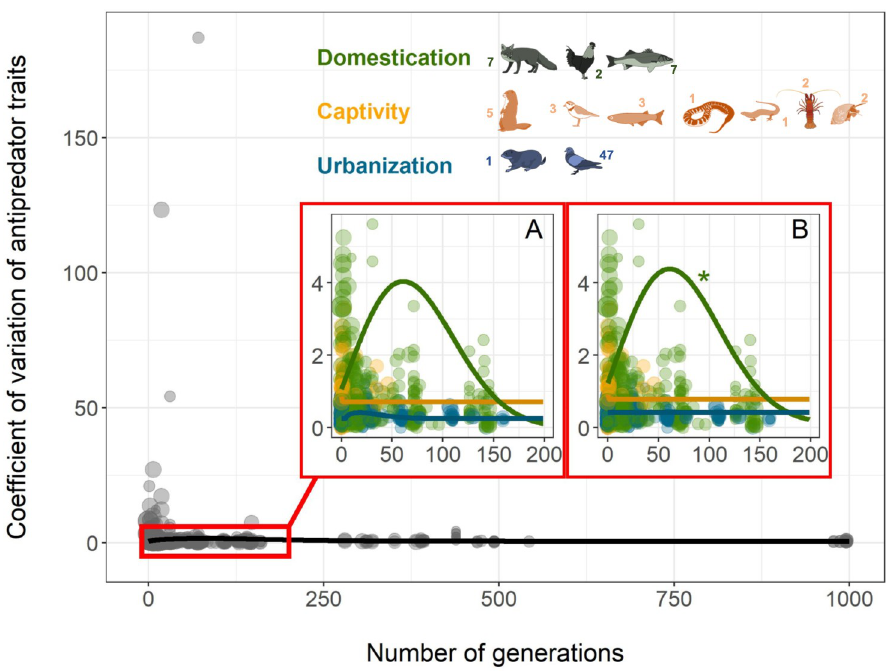
Fig 2. Effects of human presence over time on the CV in antipredator traits, black line (all contexts). (A) Lines correspond to the best loess fitting the data using the cma-es function. (B) Lines correspond to the best Weibull model with the outputs (slopes and intercepts) of the MCMCglmm for the CV. Dot size is proportional to the log- transformed number of replicates used in each study. “ � ” indicates significant p -value < 0.05 of the Weibull slopes with the MCMCglmm model (S1 Table). The number associated with each animal indicates the number of species in each of the following taxa: Mammals, Birds, Reptiles, Fish, Amphibians, Arthropods, and Mollusks. All data and R code supporting the figure are available in S1C Data. Species design: Pierre Lopez (MARBEC). cma-es, covariance matrix adapting evolutionary strategy; CV, coefficient of variation; MARBEC, Marine Biodiversity, Exploitation and Conservation; MCMCglmm, Markov chain Monte Carlo generalized linear mixed